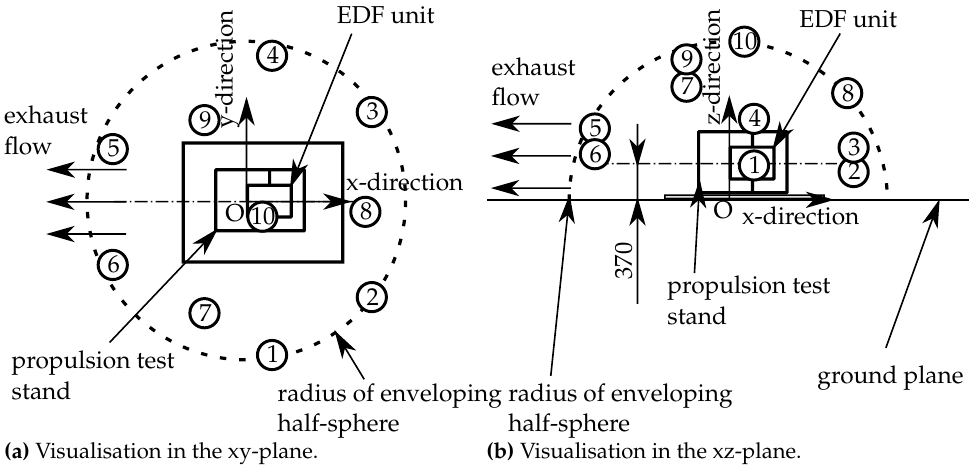
Figure 6. Visualisation of the microphone positions for the measurements relative to the propulsion test stand. The numbers in the figure describe the positions where a microphone is